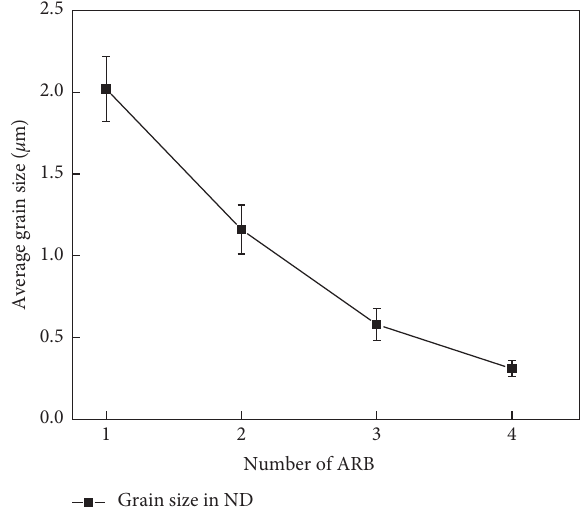
Figure 6: Dependence of Al grain size in the ND on the number of the ARB